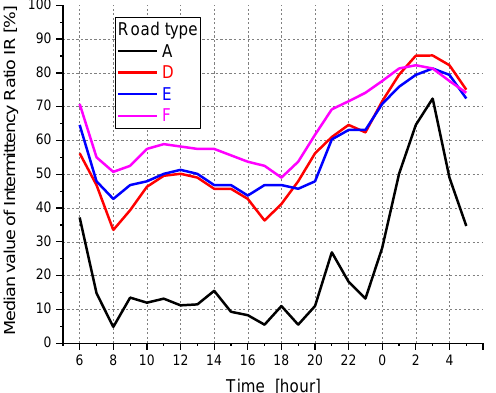
Figure 9. The median values of the hourly IR for each hour and type of road.